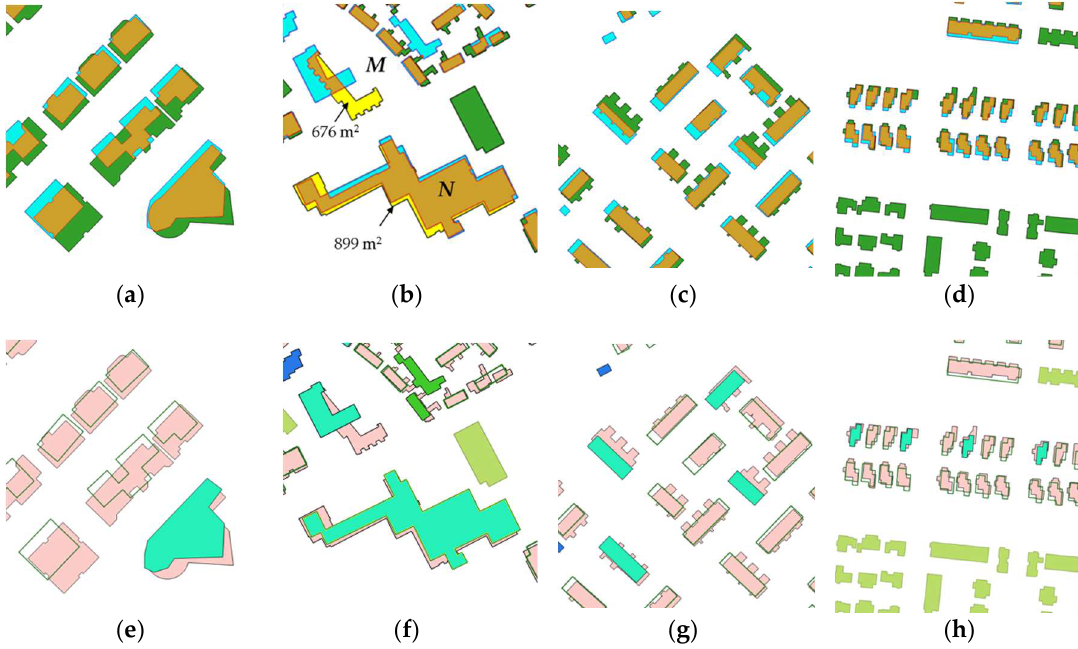
Figure 1. Typical discrepancies between OpenStreetMap (OSM) (~1:10,000) and our dataset at 1:10,000: ( a – d ) the more current OSM data A is in green and to-be-updated data B is in cyan; color blending shows A–B in green, B–A in cyan, and A ∩ B in brown; changes detected in each situation using basic geometric analysis alone are shown in ( e – h ), where A is in pink, B is hollow polygons with bold outlines, and detected changes in both A and B are highlighted with color fills and contain false positives.